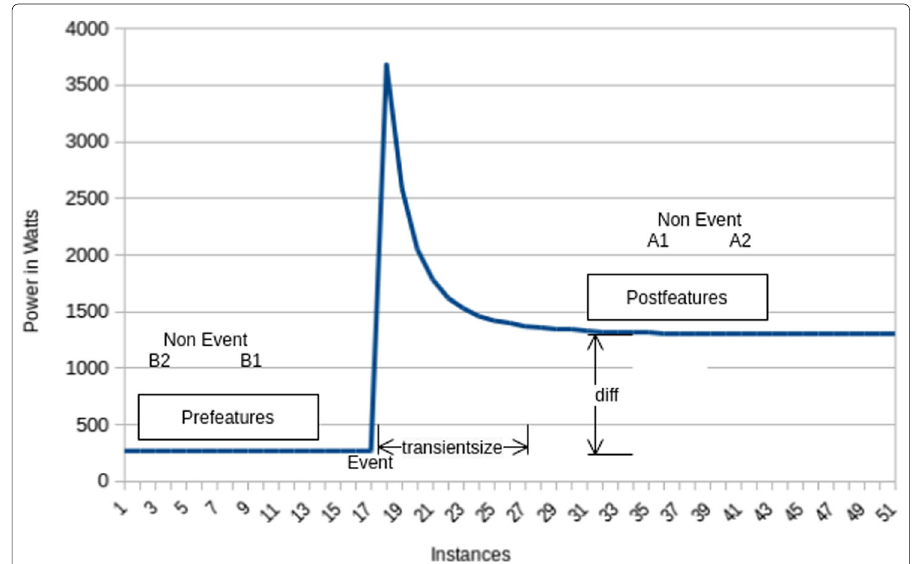
Fig. 3 Power changes due to ON event of Vacuum